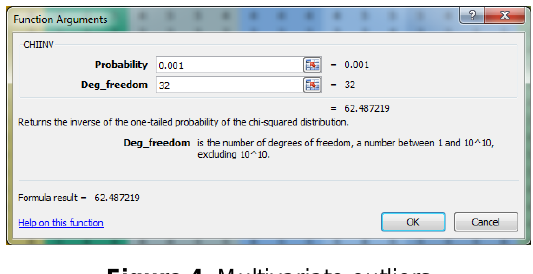
Figure 4. Multivariate outliers